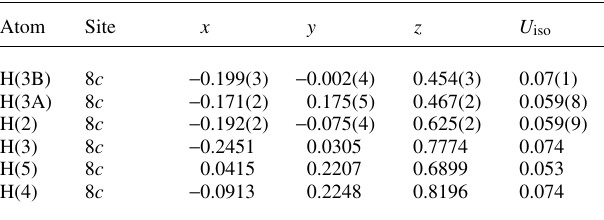
Table 2. Atomic coordinates and displacement parameters (in Å 2 )